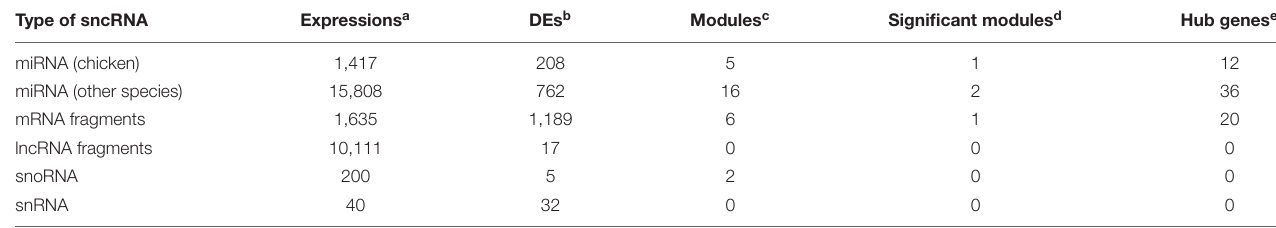
TABLE 1 | Summary of the quantitative information obtained from 5 types of sncRNA